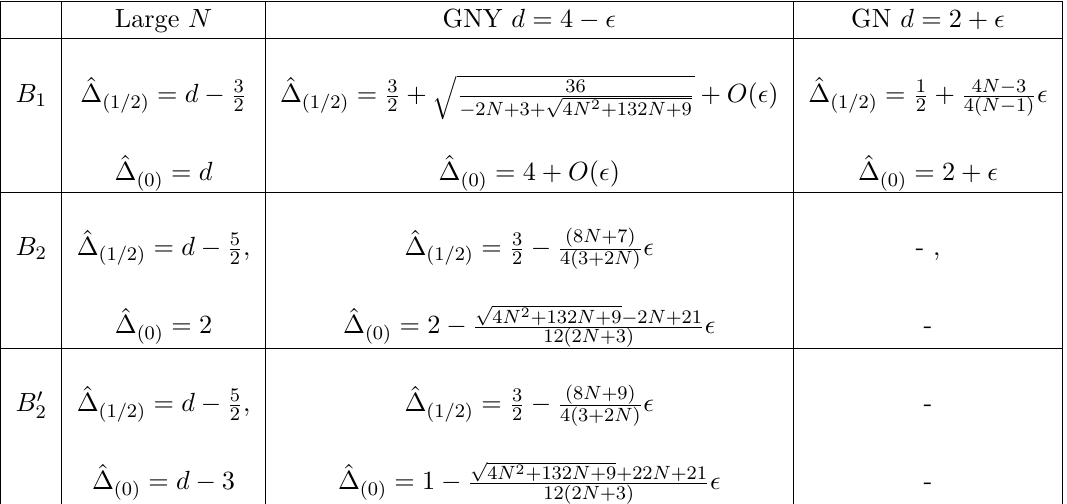
Table 1 . The dimensions of the leading boundary operators induced by the bulk fundamental fields Ψ and σ at large N in the three boundary phases we find. We also show the corresponding results from (cid:15) near two and four dimensions. The phase in the first row exists for 2 < d < 4 , while the two phases in the bottom two rows only exist between 3 < d < 4